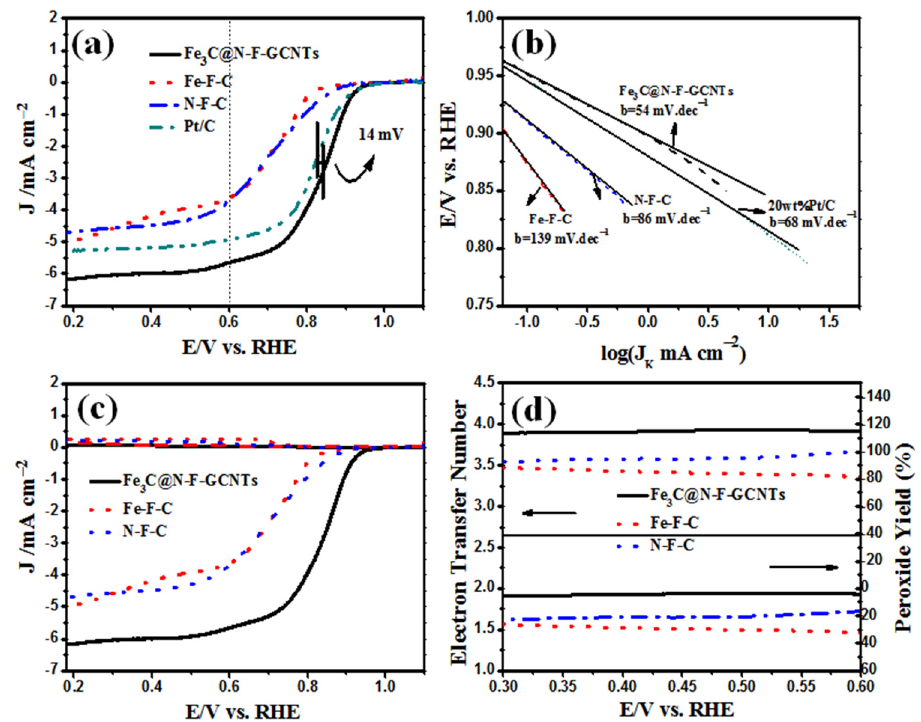
Figure 5. LSV curves of Fe 3 C@N-F-GCNTs, Fe-F-C, N-F-C, and 20 wt.% Pt/C in O 2 -saturated 0.1 M KOH solution at 1600 rpm ( a ); the corresponding Tafel slopes ( b ); RRDE voltammograms in 0.1 M KOH solution at a rotation rate of 1600 rpm ( c ); and the calculated peroxide yields (%) and electron transfer numbers (n) ( d ) of Fe 3 C@N-F-GCNTs, Fe-F-C, and N-F-C.